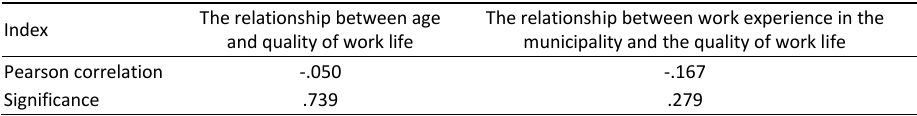
Table 2: Correlation between quality of life, age, background in the municipality and outside the municipality Index